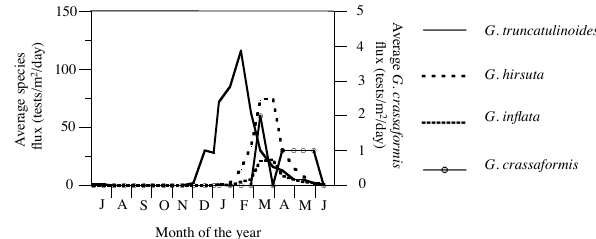
Figure 8. Seasonal succession for deeper-dwelling species averaged over six spring blooms (1998, 1999, 2000, 2008, 2009, 2010) from the 1500m trap. G. truncatulinoides, G. hirsuta , and G. inflata ap- pear on the left axis and G. crassaformis is on the right